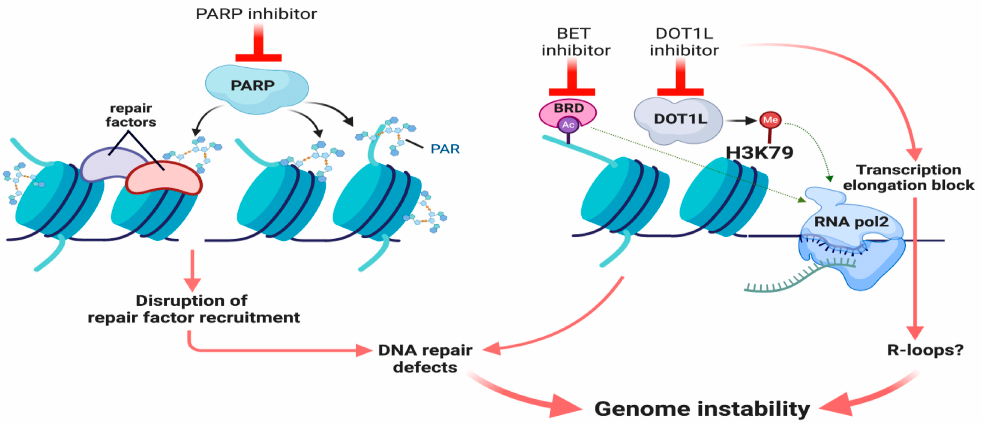
Figure 2. Model for DNA repair- and/or epigenetics- based combinatorial therapies. PARP inhibitor prevents poly-ADP-ribosylation (PAR) of histone or non-histone proteins to disrupt repair factor recruitment. Acetylation (Ac) ‘reader’ Bromodomain (BRD)-containing proteins or DOT1L-mediated H3K79 methylation promote transcription elongation (green dotted line). BET inhibitor or DOT1L inhibitor could impede RNA polymerase II (pol2) progression to cause R-loop formation, or directly disrupt DNA repair. Thus, the combination of these three drugs could effectively compromise genome stability in cancer cells.